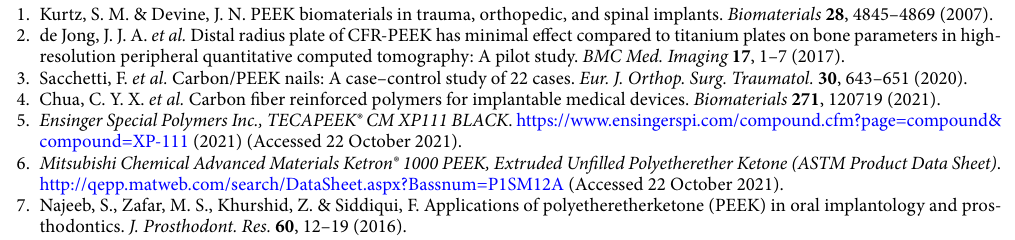
Fig. 9c. The procedure was performed following the general protocol of the kit. After 3 weeks of culture, DMMB dye reagents were added to samples lysed in deionized water. Subsequently, after draining from the mixture, the insoluble sGAG-dye complex was dissolved by mixing with a dissociation reagent, including sodium salt, of an anionic surfactant. When all of the bound dye had been dissolved, the mixture was centrifuged at 12,000 rpm for 5 min to remove the form completely, and the absorbance of the mixture was recorded at 650 nm. Finally, an aliquot of 0–10 mg mL −1 standards was prepared using a sterile solution of bovine tracheal chondroitin 4-sulfate. Ca deposition, which expresses ECM mineralization, was evaluated by alizarin red S staining (Fig. 9d). After 3 weeks of culture, the cells on the surfaces were fixed with 75% ethanol for 1 h and stained with 1% alizarin red S solution (Sigma-Aldrich, St. Louis, MO) at room temperature for 30 min. The unbound stain was repeatedly removed with distilled water. After, Ca nodules on the substrates were observed and photographed (Fig. 9f). For quantitation, the bound stains were eluted with 10% cetylpyridinium chloride in 10 mM sodium phosphate; the optical density was measured at 570 nm. CPEEK-AN originally had a certain amount of Ca, and CPEEK-AN, which has no cells, was analyzed as a control. Statistical significance analysis. All graphs show the individual raw value and standard deviation, and statistical significance was determined using the JMP (Ver 15.1.0, SAS Institute, Cary, NC, USA) statistical analysis tool. A two-tailed Student’s t-test was used when only two groups were being compared, and > three groups were ana- lyzed by one-way ANOVA followed by Tukey’s honest significant difference (HSD) test. * and **indicate statistically significant difference when directly compared to each respective group with *p < 0.05, **p <